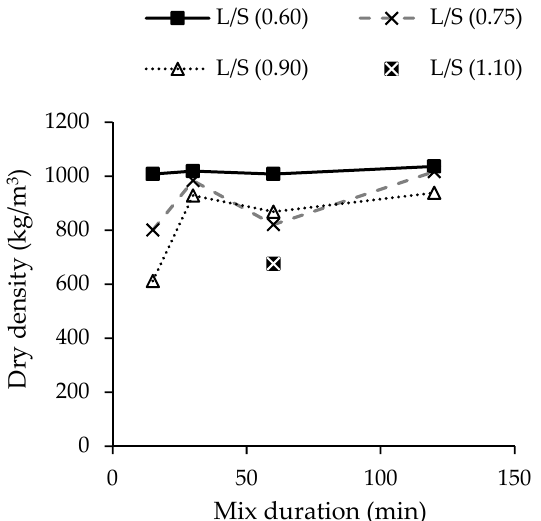
Figure 8. Influence of liquid to solid ratio and mix duration on density of alkali-activated MIBA (adapted from Chen et al. [92]).